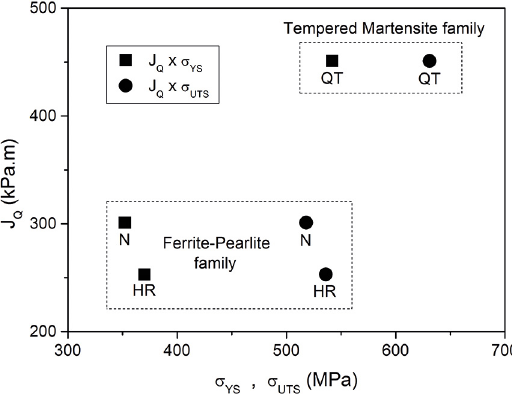
Figure 4. Fracture toughness and tensile mechanical resistance relationship. HR = hot-rolled; N = normalized; QT = quenched and